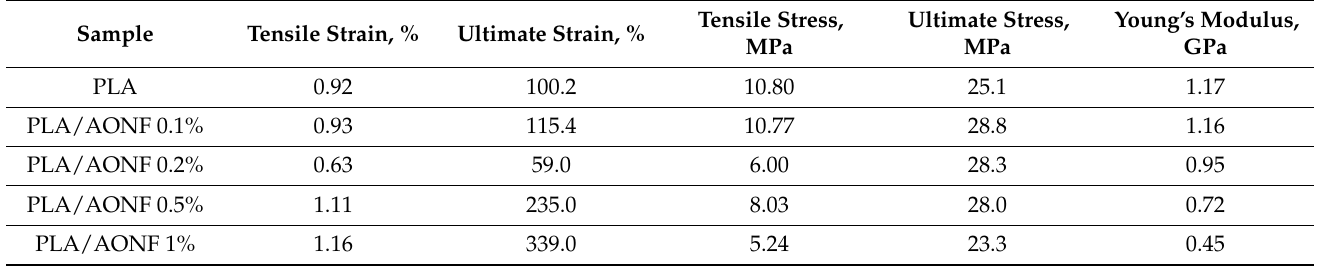
Table 2. Mechanical properties of stock material (PLA) and PLA/AONF composite